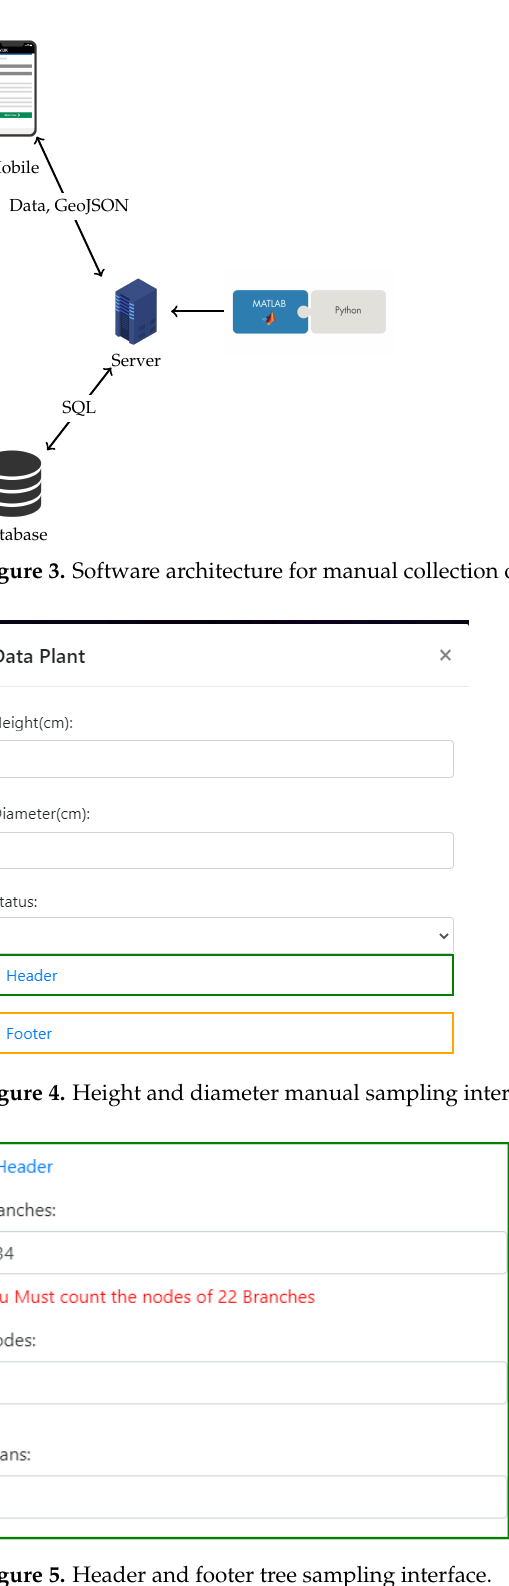
Figure 5. Header and footer tree sampling